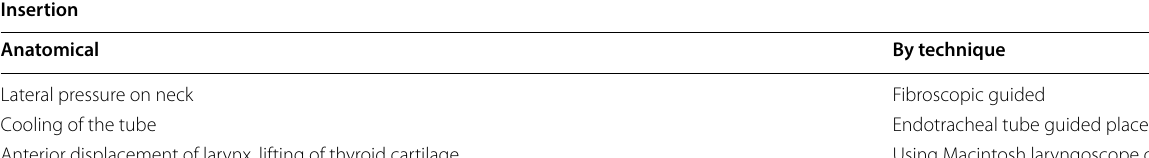
Table 4 Different techniques for NGT